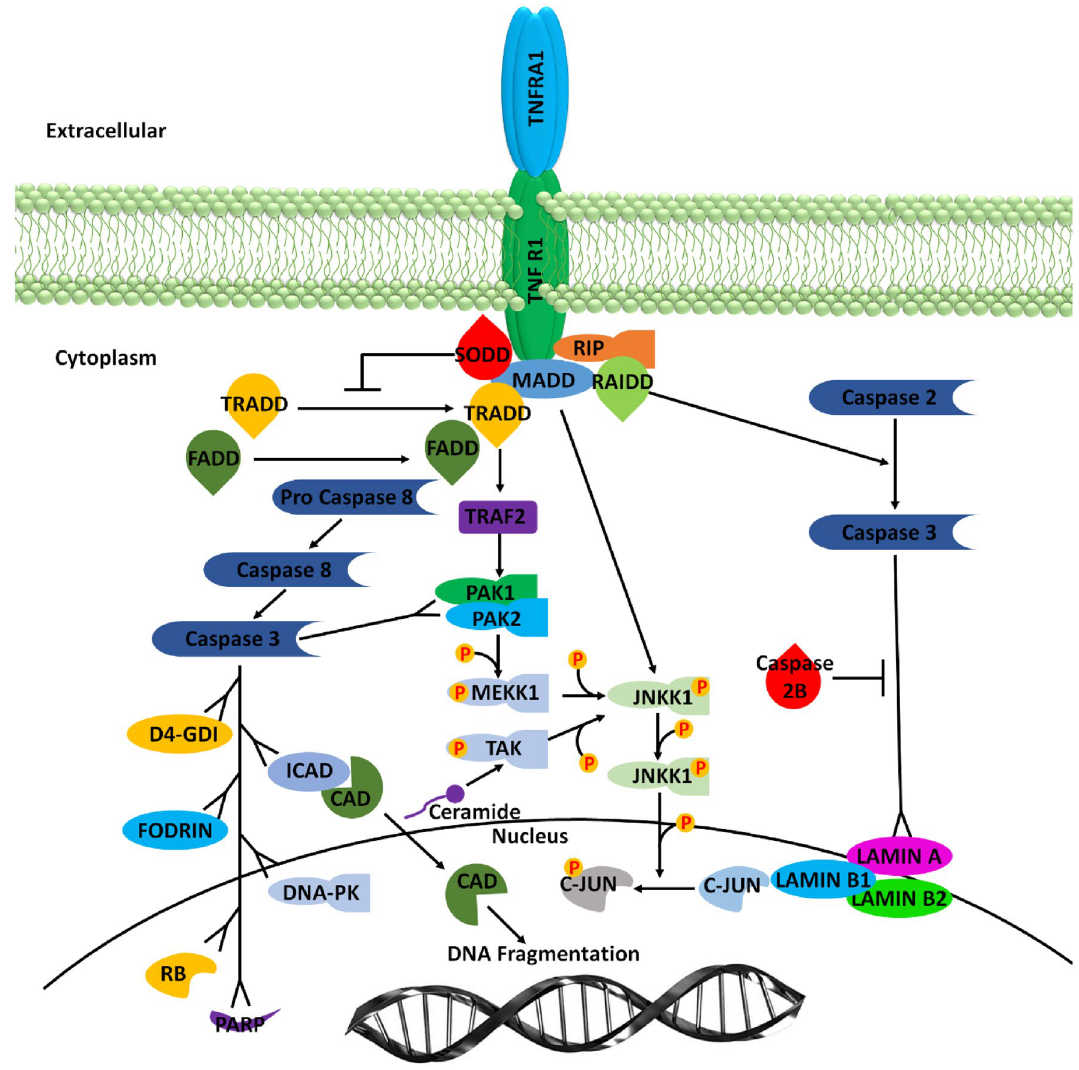
Figure 13. MADD is a key signaling protein complex localized in the cytosol which exerts its biochemical signaling via different binding factors. In humans MADD is the death domain protein that regulates the expression of Rab3 GDP/GTP exchange protein under normal circumstances via Ca 2+ dependent neurotransmitter release from the synaptic cleft and exocytosis. MADD is also reported to block the apoptosis process in neuronal cells in cytotoxic conditions of